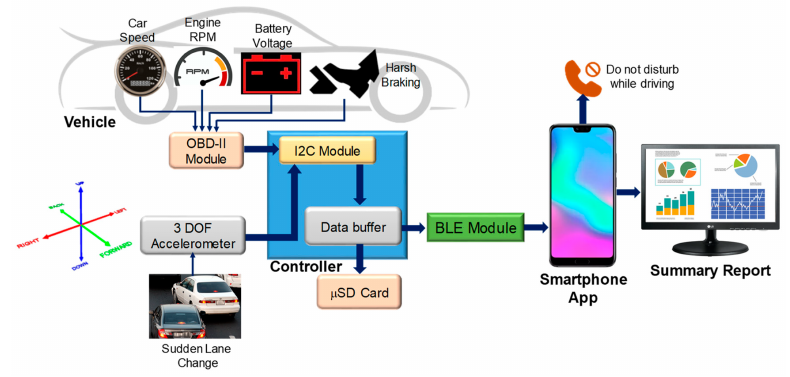
Figure 17. Complete block system diagram proposed in [26].